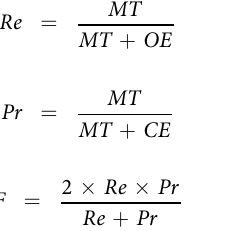
Tree segmentation evaluation. To evaluate tree segmentation, a score to each pair of LiDAR-derived tree location, assumed to be the apex of the segmented crown, and stem location measured in the field is assigned. The score is based on the tree height difference, which should be less than 30%, and the leaning angle between the crown apex and the stem location, which should also be less than 15° from nadir. The set of pairs with the maxi- mum total score where each crown or stem location appears not more than once is selected using the Hungarian assignment algorithm and is regarded as the matched trees 26, 68 . The number of matched trees (MT) is an indica- tion of the segmentation quality. The number of unmatched stem locations (omission errors–OE) and unmatched LiDAR-derived crowns apexes of which are not in the buffer area (commission errors–CE) indicate under- and over-segmentation, respectively. The tree segmentation accuracy metrics we used here were Recall (Re), Precision (Pr), and F-score (F), which are calculated using the following equations 69 :